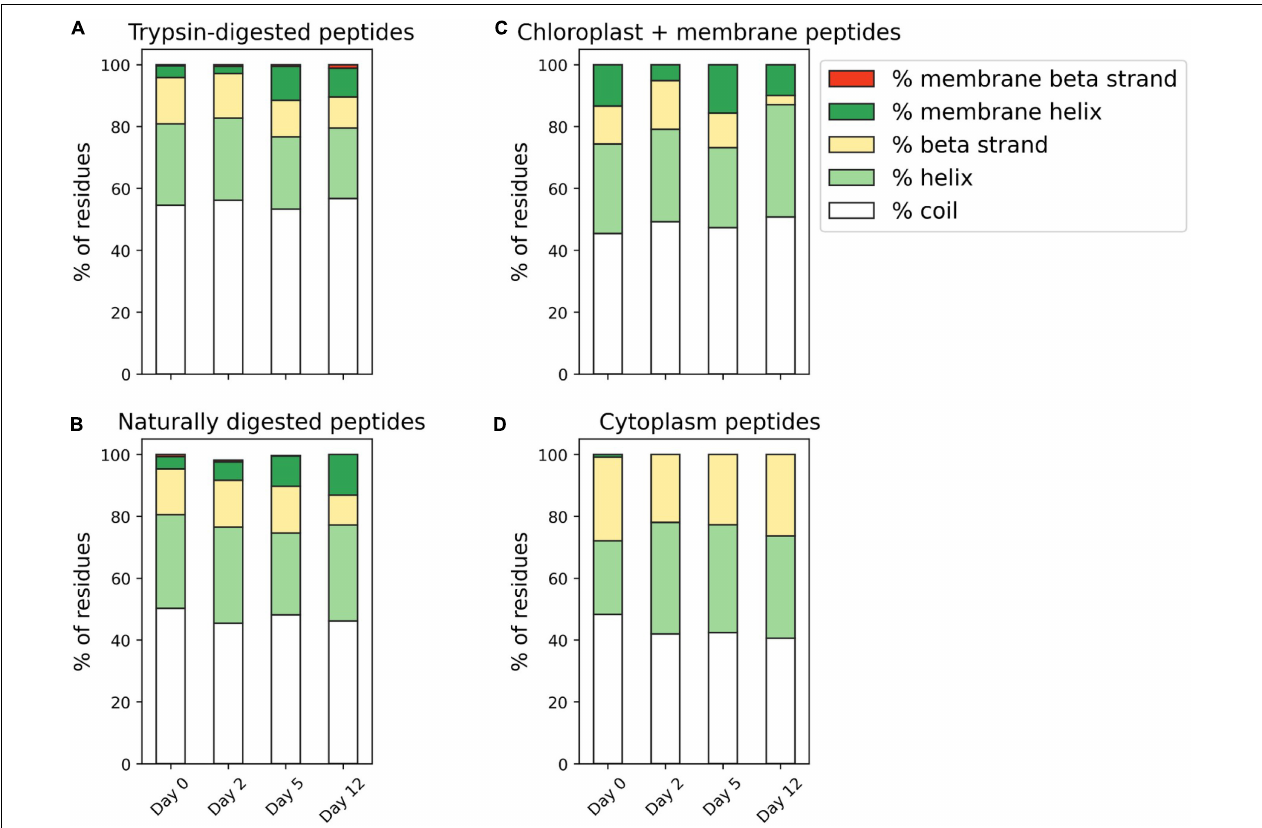
FIGURE 3 | (A,B) Secondary structure predictions of algal peptides identified in trypsin-digested and naturally digested fractions at four points during the 12-day degradation experiment. Secondary structure motifs (coil, A -helix, β -strand, membrane A -helix, membrane β -strand) were predicted from full protein sequences using Proteus2 (Montgomerie et al., 2008) and the relative contribution of motifs determined by the identifying peptide’s relative peptide area abundance. (C,D) Secondary structure predictions of just algal chloroplast and membrane peptides and algal cytoplasmic peptides that are identified at each time point of the degradation. For this comparison, proteins identified in the trypsin-digested and naturally digested fractions were combined and adjusted by relative peptide area